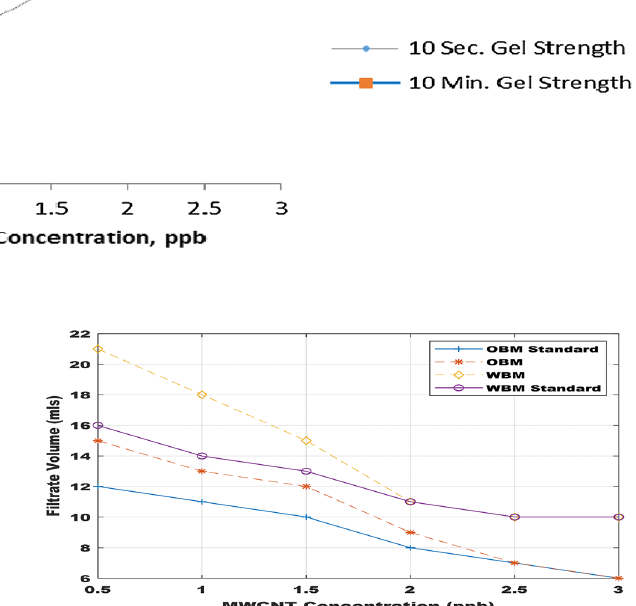
Fig. 5 Gel strength at different concentrations of MWCNT for WBM